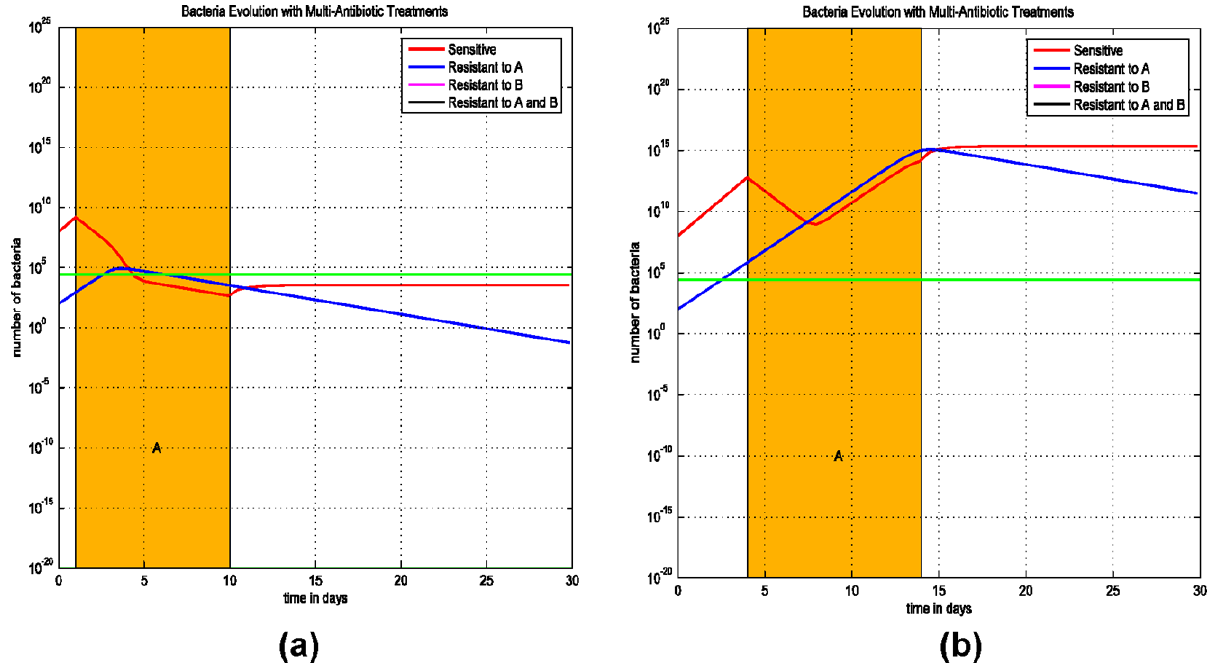
Figure 2. Simulations of Model (1) on the initiation of an antimicrobial therapy and infection progression. (a) Treatment starts at the 1 st day after an infection and lasts for 9 days. The bacterial load decreases to below the threshold and the infection is prevented. (b) Treatment starts at the 3 rd day after an infection and lasts for 9 days. The bacterial load decreases slightly, but stays above the threshold and increases even during the treatment.